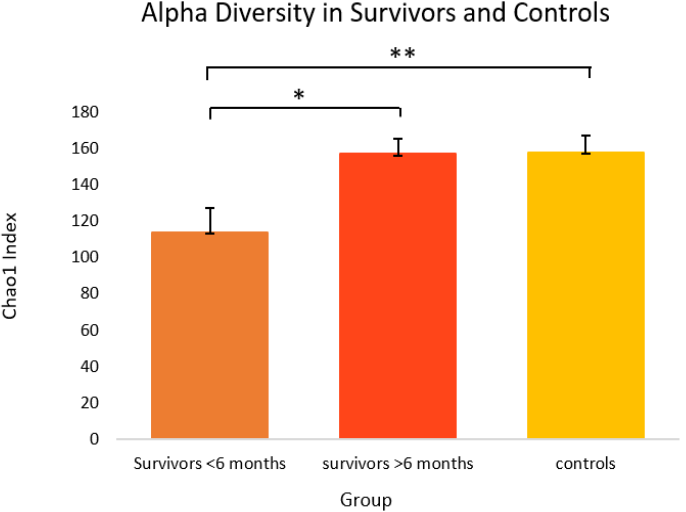
Figure 1. Alpha diversity on the Chao1 index in cancer survivors and healthy controls. Group means are presented. Significance is denoted by * at the p < 0.05 level, and ** at the p < 0.01 level. Error bars represent standard error of the mean (SEM). Group n = 7, 10, and 18, respectively.